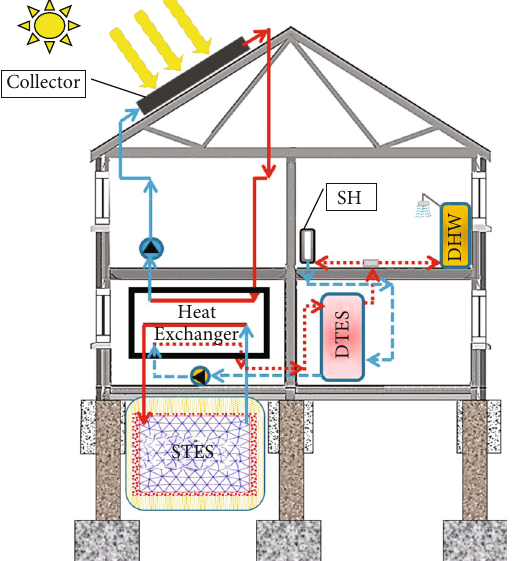
Figure 1: Seasonal thermal energy storage and solar combisystem schematic diagram in a building. ∗ STES: seasonal thermal energy storage; DTES: diurnal thermal energy storage; SH: space heating; DHW: domestic hot